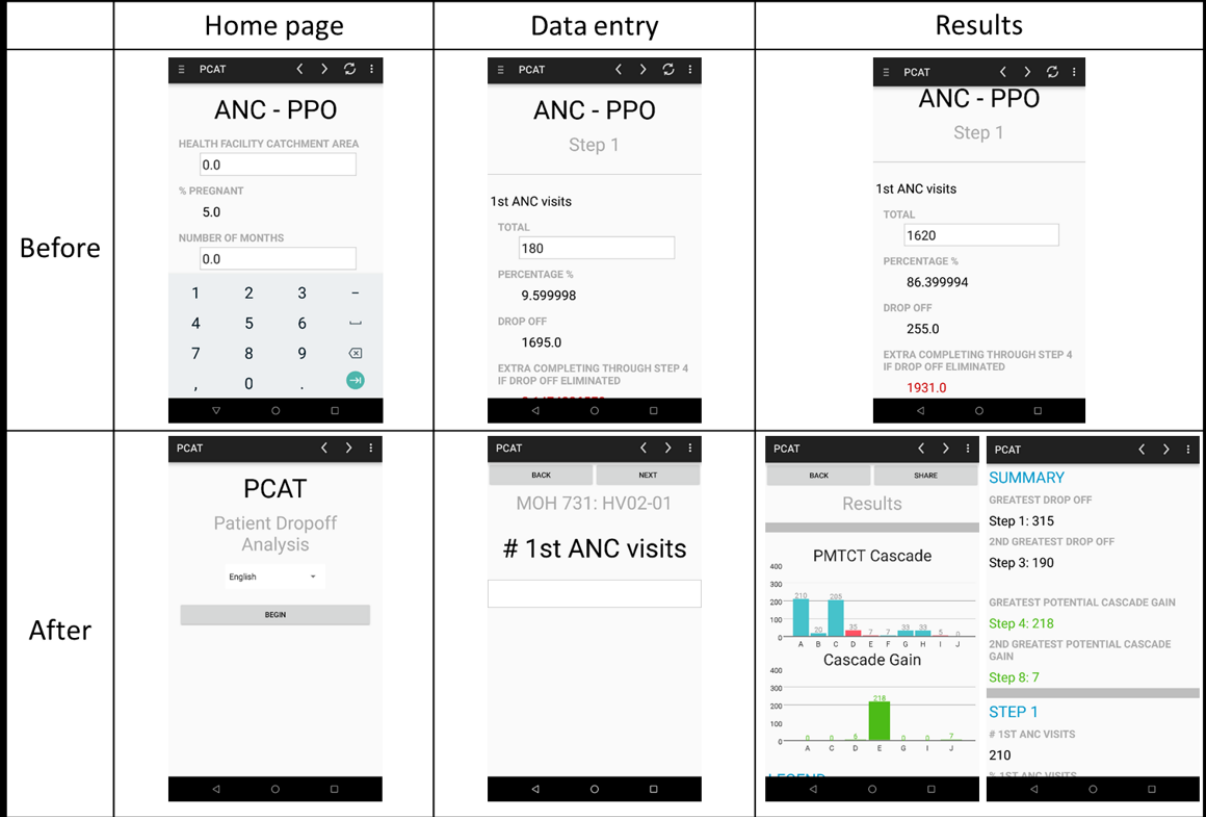
Figure 1. Screenshots of home page, data entry page, and results page before and after mobile phone–based prevention of mother-to-child HIV transmission cascade analysis tool usability testing. ANC: antenatal care; MOH: Ministry of Health; PCAT: prevention of mother-to-child